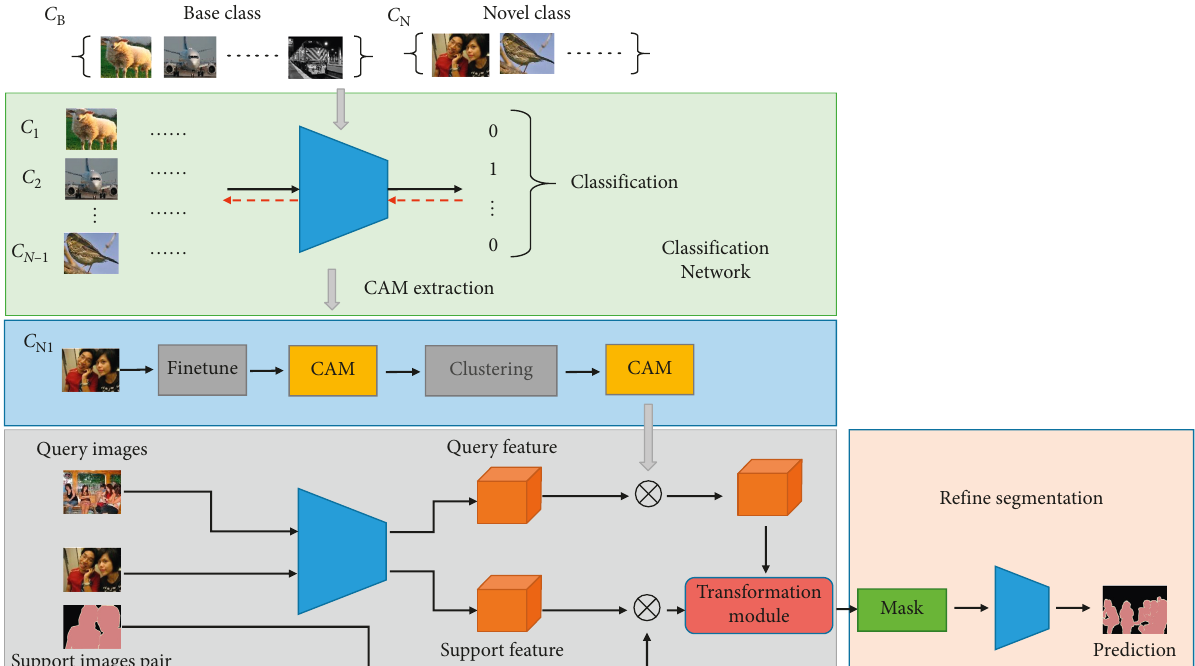
Figure 1: The pipeline of the proposed